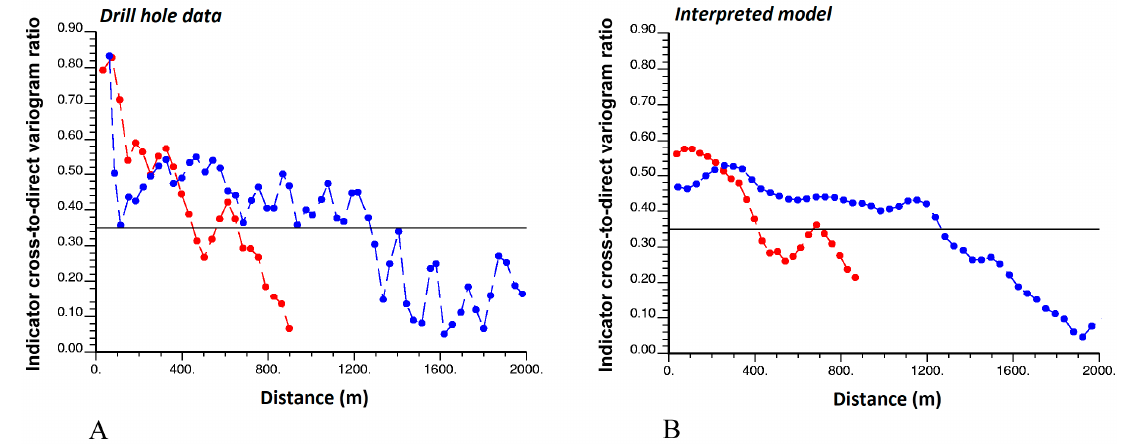
Figure 12. Absolute value of the ratio of indicator cross-to-direct variograms between rock types 3 (sedimentary rocks) and 2 (other volcanic rocks) along directions dipping 30° (blue) and − 60° (red) with respect to the north direction, calculated from ( A ) drill hole data, ( B ) interpreted model. Calculations consider an angle tolerance of 20° around the target directions. The same lag values have been used for both variogram ratios. The expected sill value (Equation (20)) is represented by a black solid line.